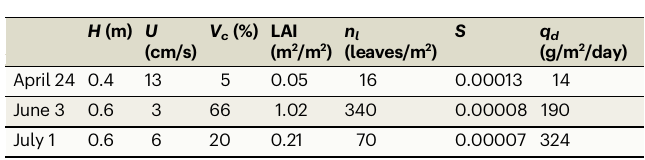
Table 1 | Field data in Cubits Gap